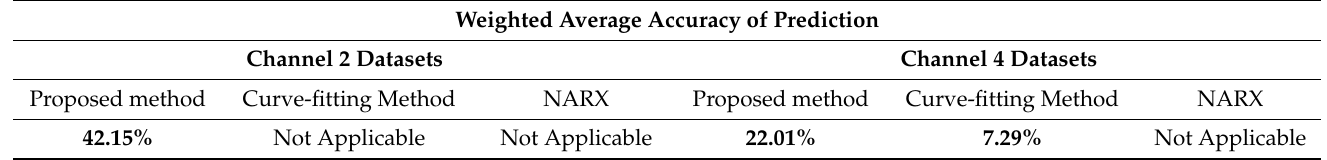
Table 6. The weighted average accuracy of prediction for channel 2 and channel